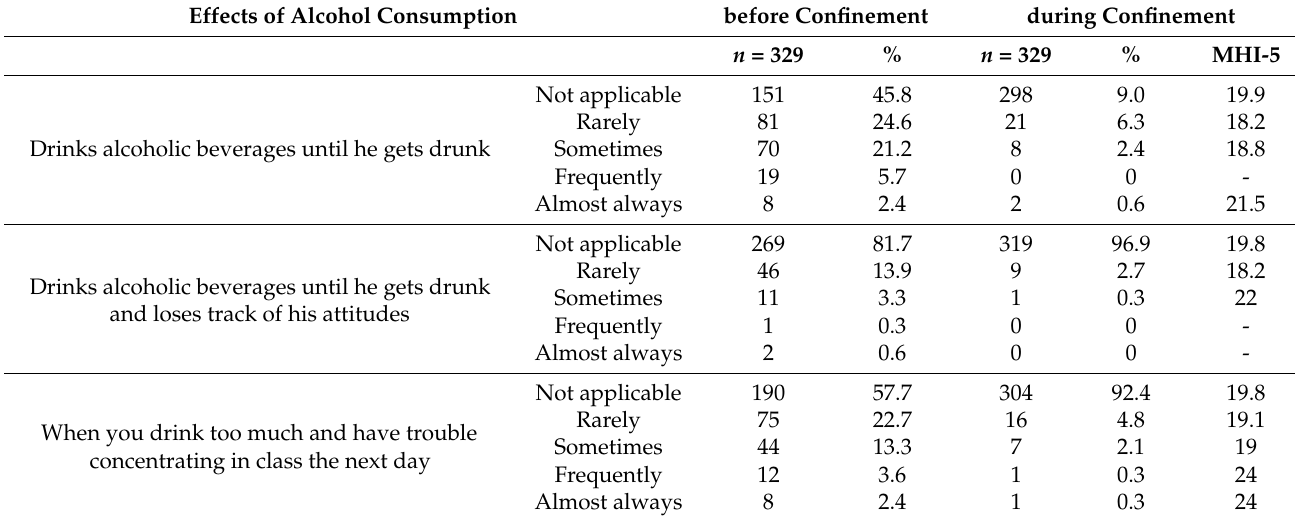
Table 3. Effects of alcohol consumption before and during